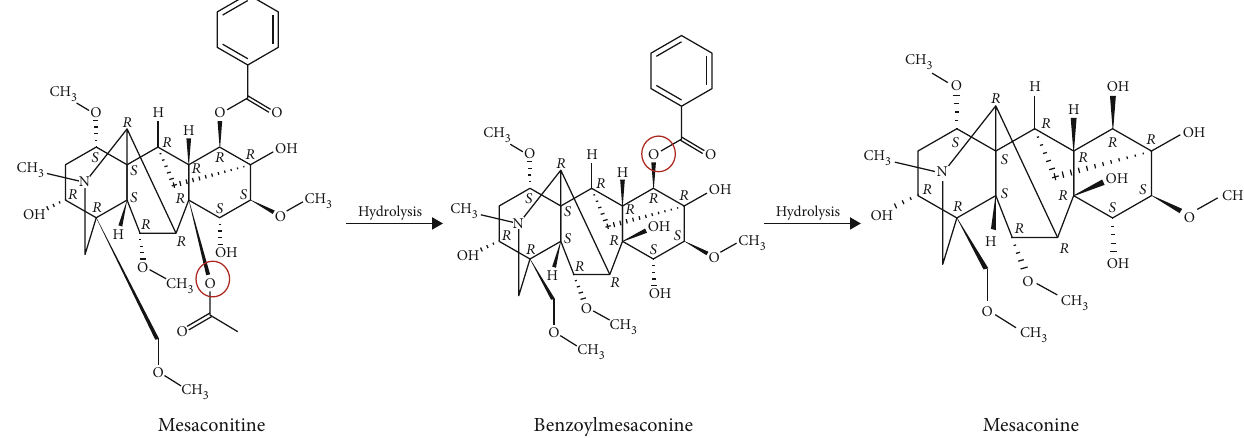
Figure 1: Absolute stereochemistry of mesaconitine and